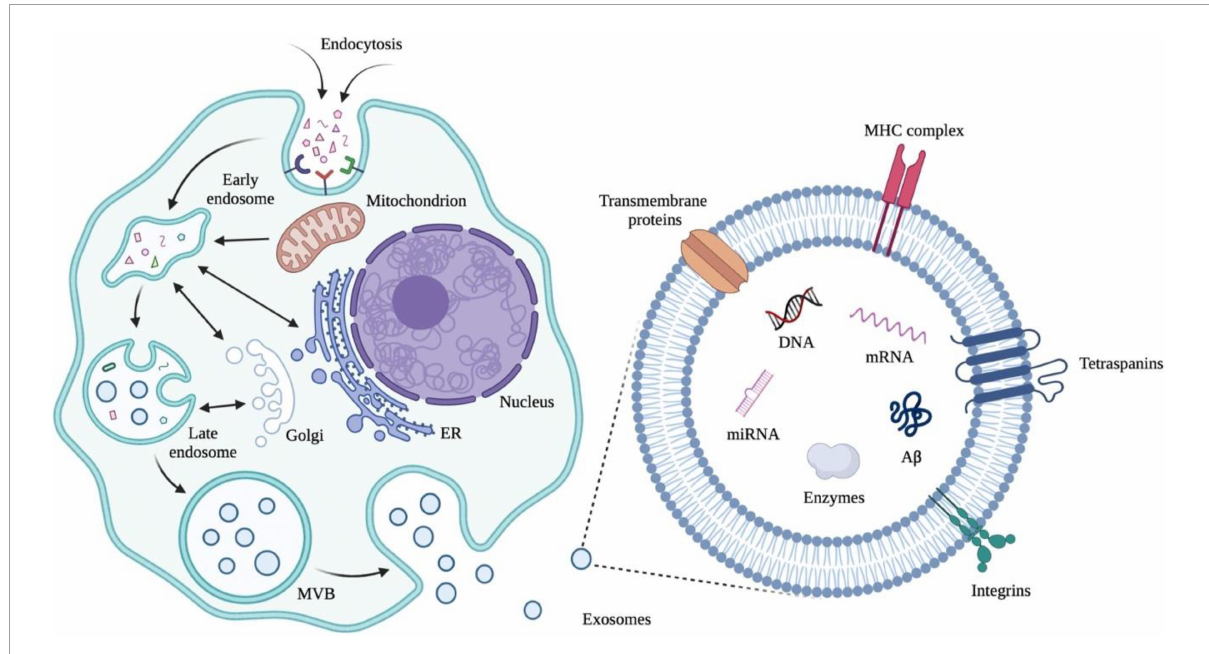
FIGURE5 Early endosomes are generated from extracellular cargos as well as cell surface proteins through endocytosis. Mitochondria, endoplasmic reticulum (ER), and Golgi are involved in the formation of multivesicular bodies (MVBs) from early endosomes through fusion. MVBs can fuse with plasma membranes and release exosomes, which are membrane nanovesicles that contain plasma-membrane- and cytosol-associated molecules such as nuclear acids and proteins both inside and outside the vesicles. Illustrations were generated using